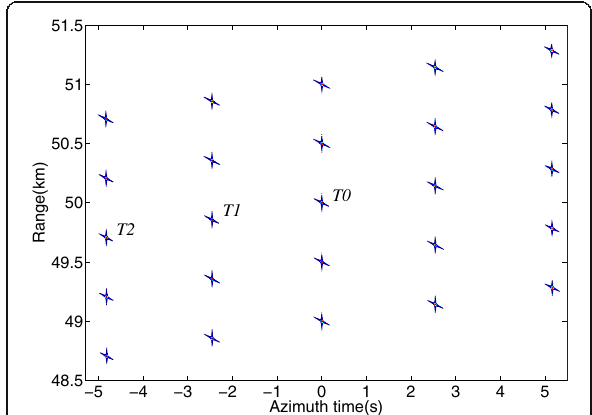
Fig. 12 Entire focused images by the proposed algorithm in case